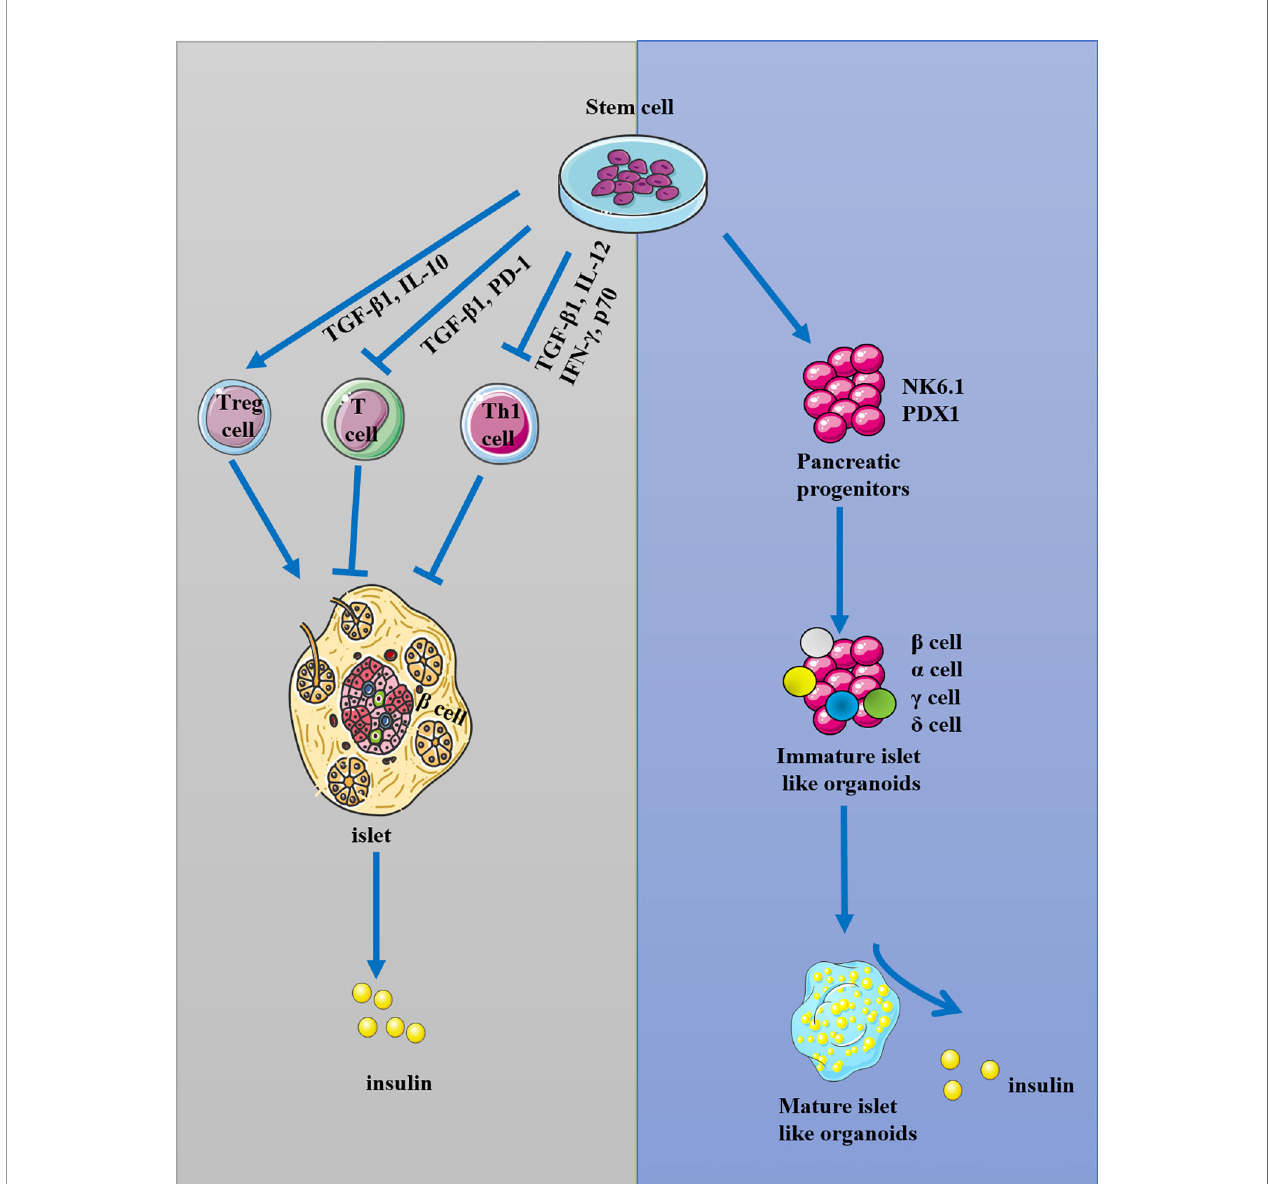
FIGURE 1 | The possible mechanism of stem cells in the treatment of T1DM. Stem cells were used for the reconstitution of immunotolerance through activating T regulatory cells (Treg) and inhibiting T and Th1 cells, and they could also be used for the preservation and regeneration of b